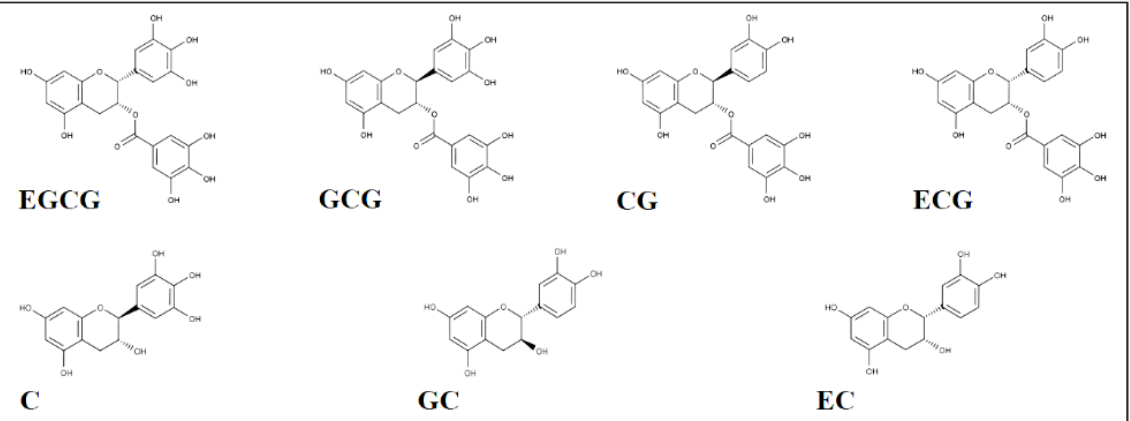
Figure 1. Structure of catechins. EGCG: epigallocatechin gallate; GCG: gallocatechin gallate; CG: catechin gallate; ECG: epicatechin gallate; C: catechin; GC: gallocatechin; EC: epicatechin. Finally, ECG displayed a lower inhibitory power with respect to both GCG and CG.